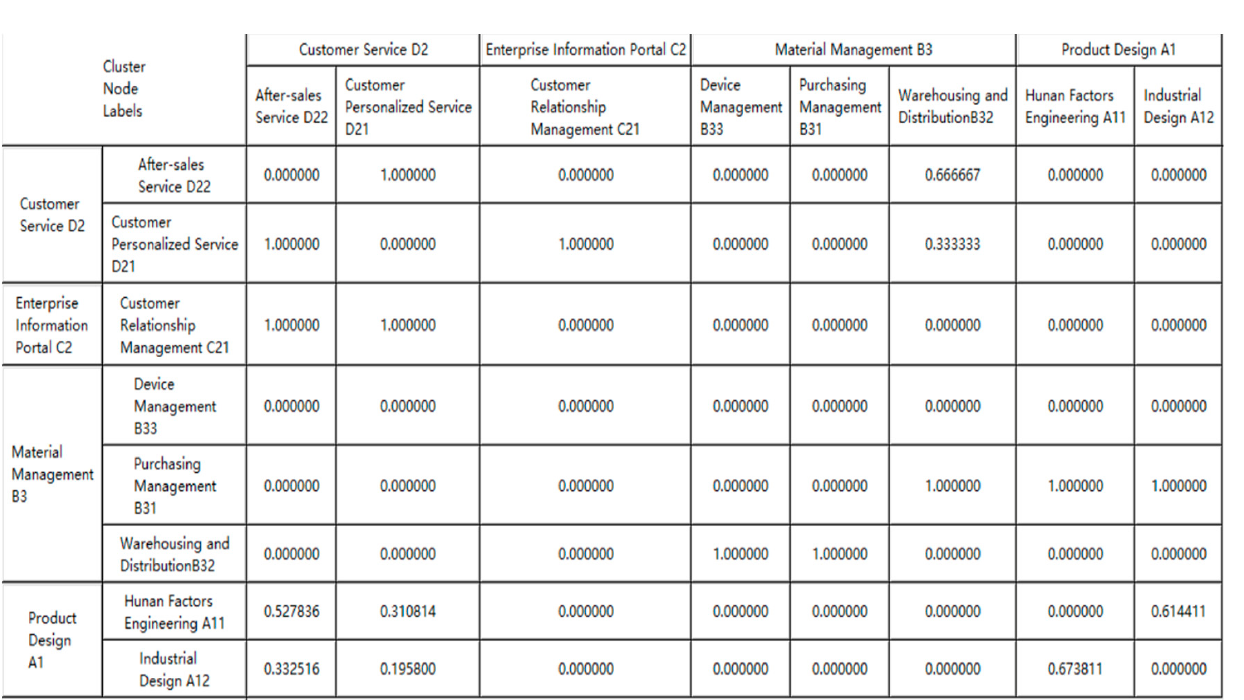
Figure 7. Unweighted hypermatrix (partial data) exported by SD software.